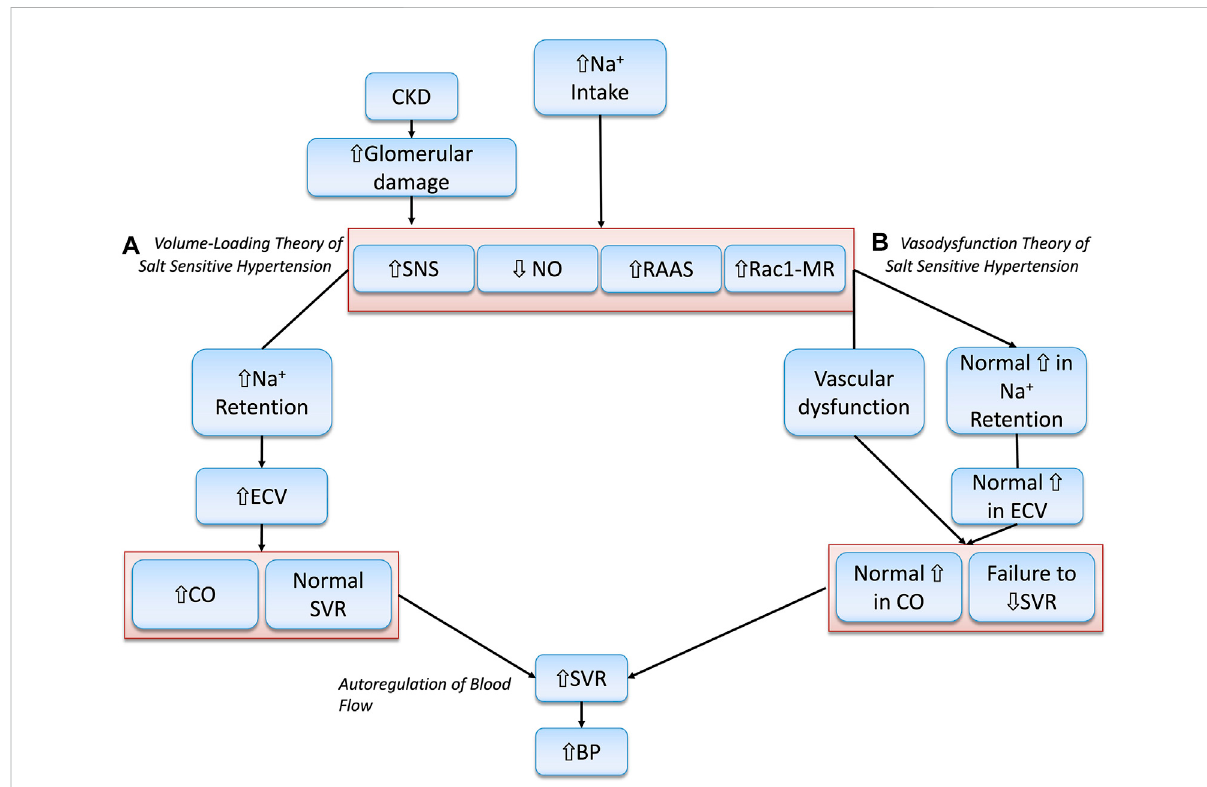
FIGURE 2 IllustrationoftheVolume-Loading ” theoryand the “ Vaso-dysfunction ” theories ofSalt-SensitiveHTN. (A) Abnormally increasedNa+ retention, ECV and CO are the principal drivers of salt-sensitive HTN according to the “ Volume-loading ” theory. (B) This is in disagreement with the “ Vaso- dysfunction ” theory of salt-sensitive HTN that considers vascular dysfunction, or compromised ability to lower SVR, as the chief initiator of salt- sensitivity